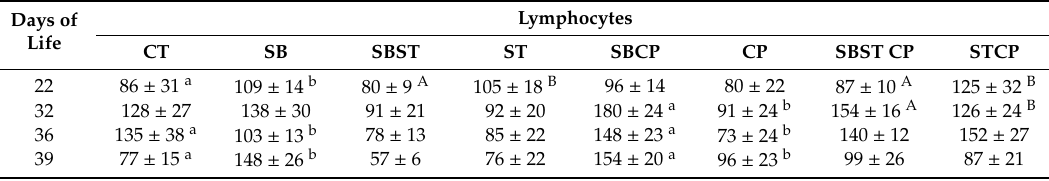
Table 2. Synbiotic e ff ect on the number of lymphocytes per bursa follicle in broilers challenged with Salmonella typhimurium and Clostridium perfringens .